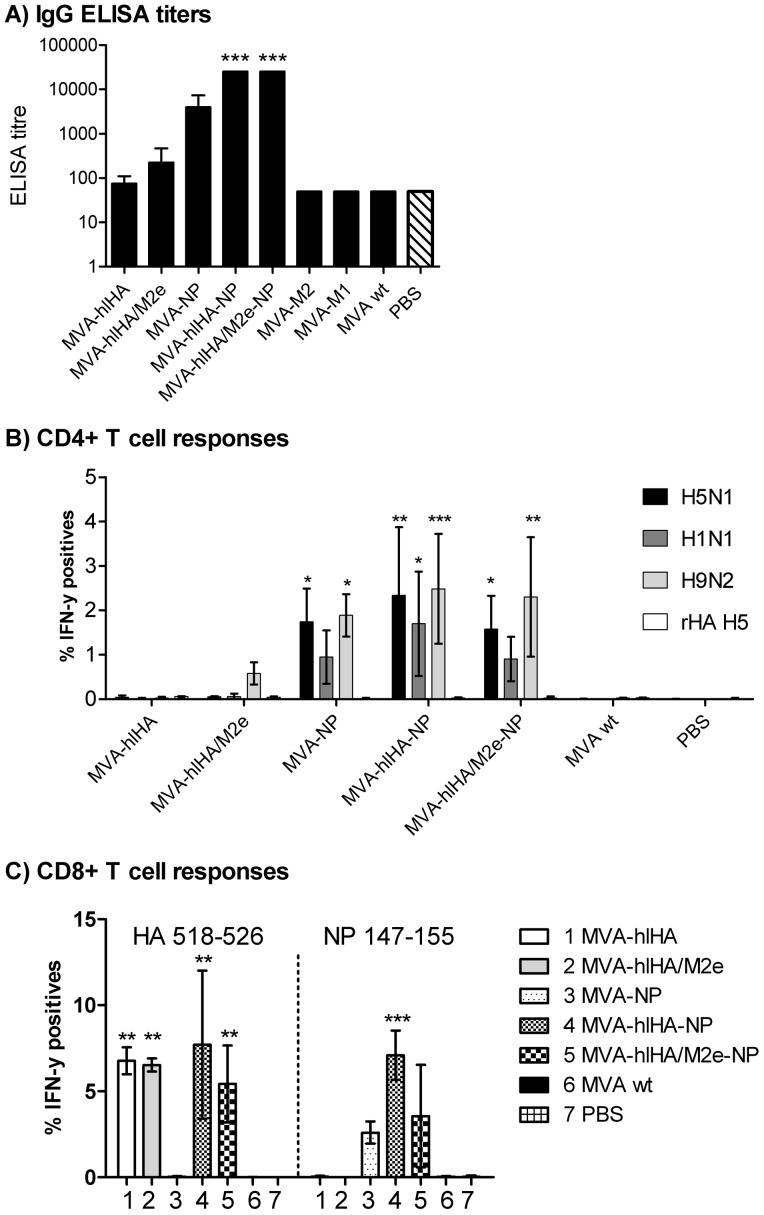
Antibody and T cell responses.(A) ELISA titers against whole-virus H5N1. The starting dilution of the assay is 1∶100. (B) Percentage of CD4+ T cells reacting to whole-virus H5N1, H1N1 and H9N2 and to recombinant H5 hemagglutinin (rHA H5) antigen after immunization of mice with MVA vectors. (C) Percentage of CD8+ T cells reacting to HA and NP peptides. Asterisks denote statistical significance calculated by two-way ANOVA and Bonferroni posttests (*p<0.01, **p<0.001, ***p<0.0001).